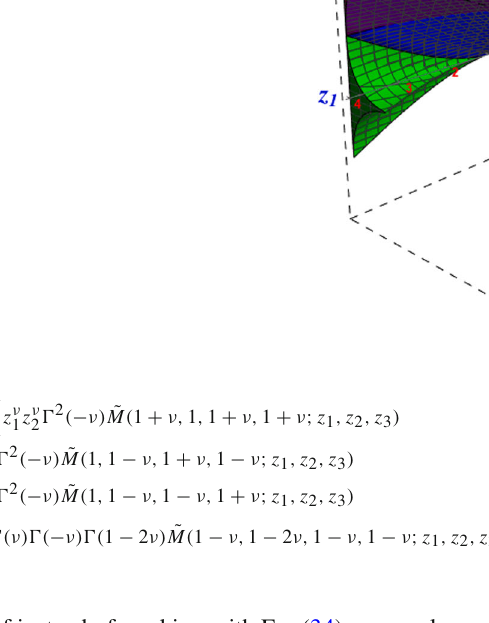
Fig. 10 Left Regions of validity, for real z i , of Eq. (55), in blue, and of Eq. (56), in purple. Right view from